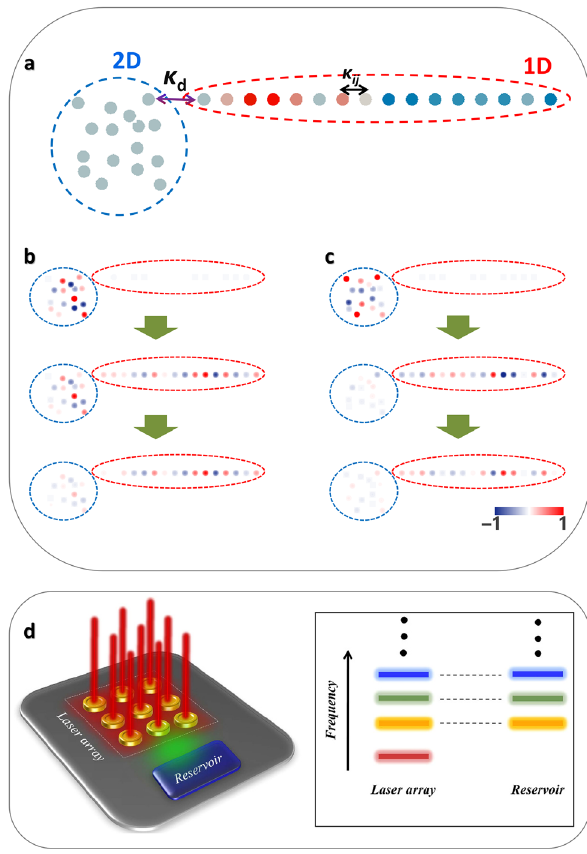
Figure 6: Interdimensional wave transport. (a) A schematic for the interdimensional coupling of 2D and 1D structures [74]. The 1D structure is obtained from the Householder tridiagonalization of the 2D structure. Each atom corresponds to a unit optical element such as an optical waveguide or resonator. κ d and κ ij represent the coupling between isospectral partners and internal coupling, respectively. (b and c) Interdimensional wave transport between the structures for the (b) 3rd and (c) 9th eigenmodes[74].(d)Singlemodetwo-dimensionallaserarraysusing SUSY and Householder transformations [81]. A 2D laser array is coupledto anopticalreservoir withgroundstateannihilation. Allthe eigenfrequencies of both subsystems are matched except for the fundamental one (indicated by the thick red line). By introducing opticalcouplingbetweenthelaser arrayandthe lossy reservoir,only thefundamentallasingmoderemains.Panels(a – c)areadaptedwith permissionfrom[74], ⓒ Optica.Panel(d)isadapted